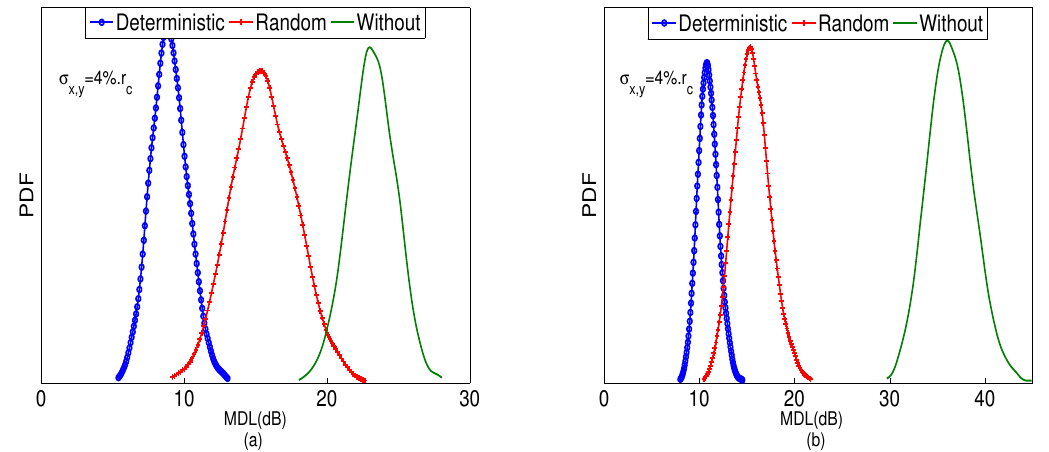
Figure 4. PDF of of MDL for different scrambling strategies and a fiber misalignment std σ x , y = 4% r c . ( a ) 6-mode fiber; ( b ) 10-mode